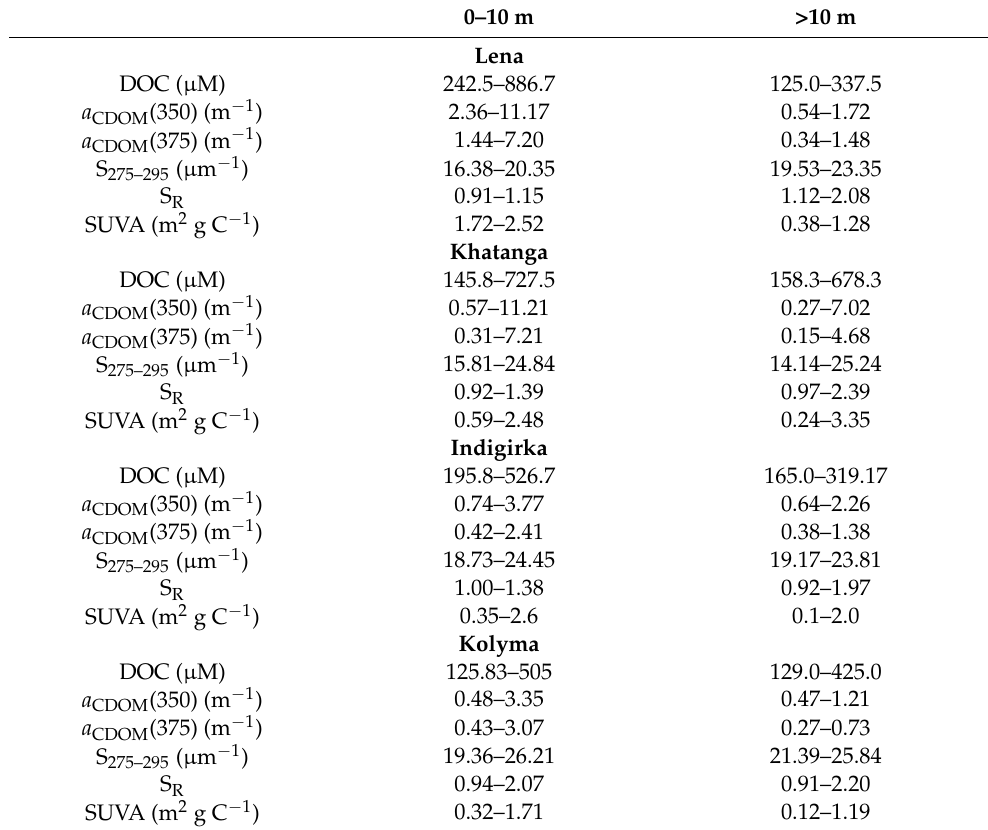
Table 2. Variation of DOC and optical characteristics of the Laptev Sea and East Siberian Sea